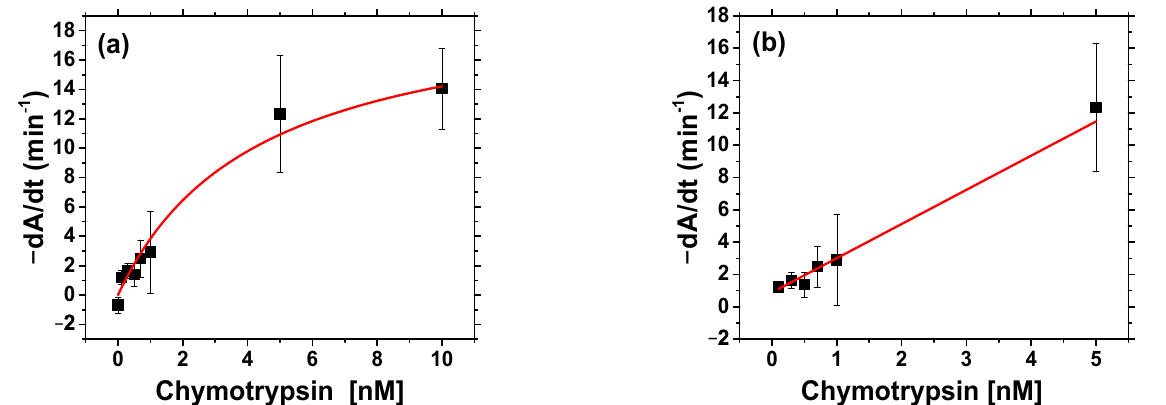
Figure 6. ( a ) Calibration curve for chymotrypsin fitted by reverse Michaelis—Menten model. dA/dt is numerical derivation of linear model of absorbance change at time t = 0 and corresponds to the rate of enzyme reaction. ( b ) Linear part of calibration curve − dA/dt vs. concentration of chymotrypsin for calculation of limit of detection (LOD). − dA/dt = (6.30 ± 0.23) × 10 − 4 min − 1 nM − 1 + (1.9 ± 0.4) × 10 − 4 min − 1 . (R 2 = 0.993), LOD = 0.15 ± 0.01 nM.